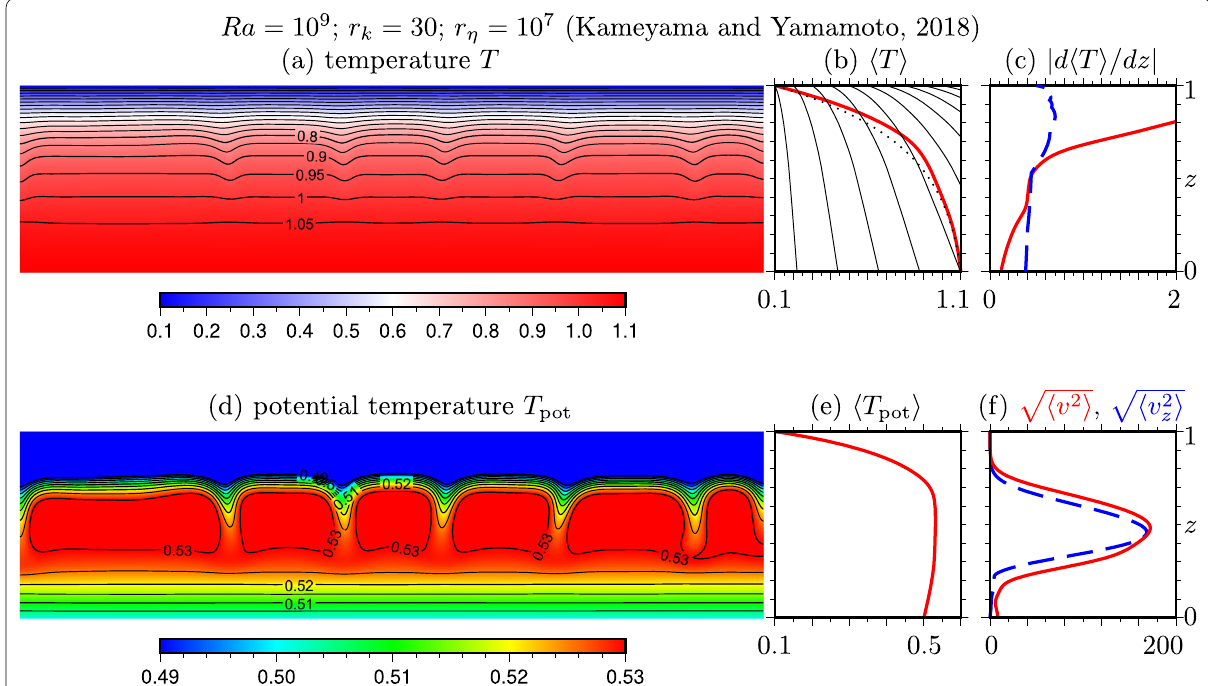
Fig. 5 An overall structure of the stagnant-lid convection of Ra = 10 9 , r k ≡ k bot / k top = 30 and r η ≡ η top /η bot = 10 7 obtained in the numerical experiments of Kameyama and Yamamoto (2018). a The distributions of temperature T . The contour interval is 0.05. The color scale is indicated at the bottom of the figure. b Plots against dimensionless height z of the horizontally averaged temperature (cid:31) T (cid:30) (thick red line) at the height of z . Also shown for comparison by thin black lines are the plots of several adiabats against z , while by dotted black lines are the vertical profiles of temperature T given by steady one-dimensional heat conduction in the vertical direction. c Plots against z of the magnitude of vertical gradient of (cid:31) T (cid:30) (red solid line) at the height of z . Also shown for comparison by blue dashed line is the magnitude of adiabatic temperature gradients given by (cid:31) T (cid:30) at z . d The distributions of potential temperature T pot . The color scale is indicated at the bottom of the figure. The contour lines for T pot are shown at the interval of 0.005 only in the range of T pot ≥ 0.49 . e Plots against z of the horizontally averaged potential temperature (cid:31) T pot (cid:30) at the height of z . f (cid:31) v 2 z (cid:30) (blue dashed (cid:31) v 2 (cid:30) (red solid line) and the vertical velocity Plots against z of the root-mean-squares of the magnitude of the velocity vector (cid:31) (cid:31) line) at the height of